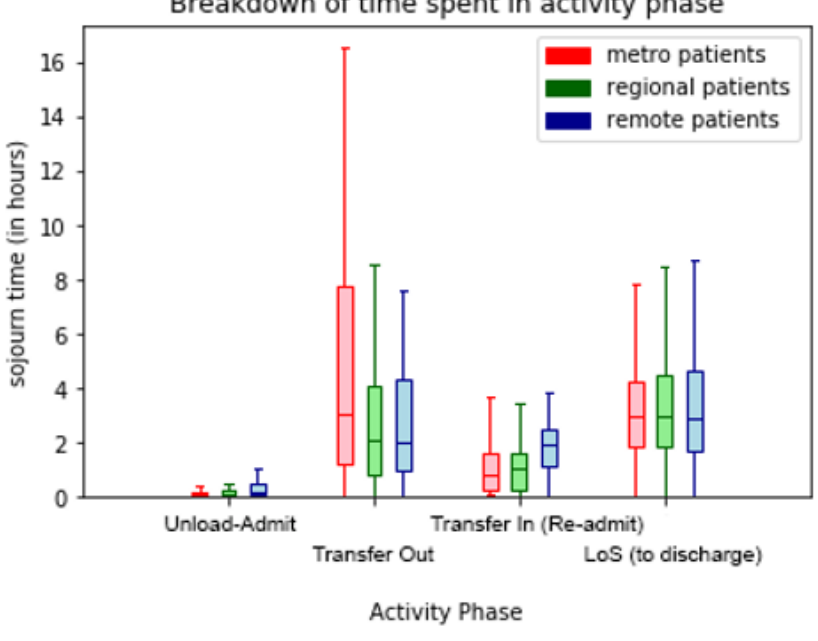
Figure 14. Comparison (by incident region) of hospital segment